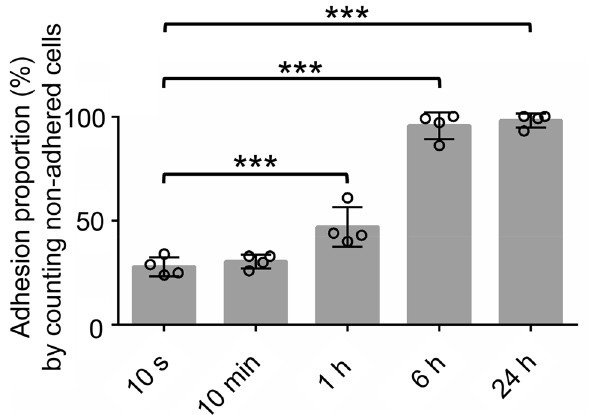
Figure 3. Quantification of numbers of adhered MSCs by counting non-adhered cells. An MSC suspension was placed on the abraded porcine cartilage, the cartilage was washed with PBS after a specified time, and the number of MSCs in the PBS that did not adhere was counted. The number of MSCs that adhered was calculated by subtracting the number of MSCs that did not adhere from the total number of MSCs that had been applied and this value was used to calculate the adhesion proportion. The number of cylindrical cartilage pieces obtained per MSC donor was 5 or 6. This experiment was repeated four times independently and plotted. Data are expressed as the average ± standard deviation (*** p < 0.001).